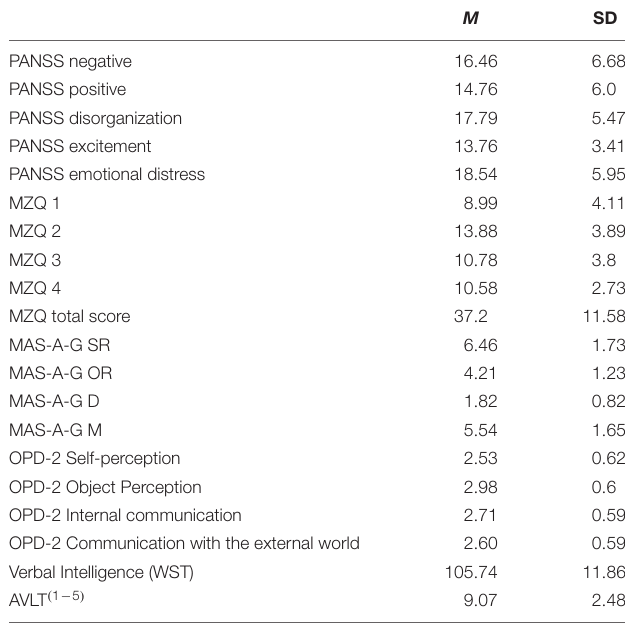
TABLE 2 | Characteristics of illness, validation tasks, and control variables in patient